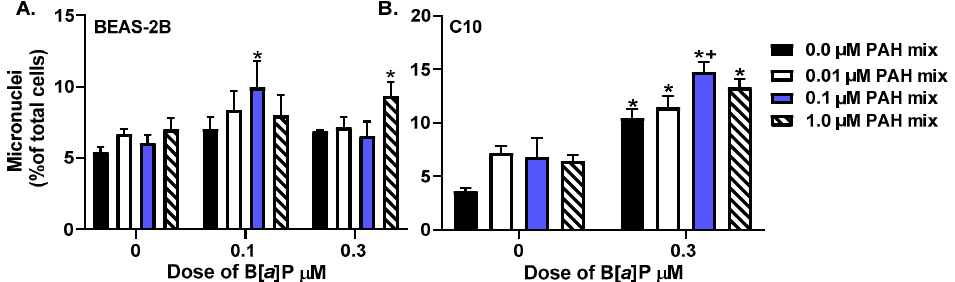
Figure 1. Micronuclei formation in human and mouse lung epithelial cells exposed to PAHs in ( A ) human BEAS-2B cells and ( B ) mouse C10 cells exposed to 0.01, 0.1, or 1 μ M of the LMW PAH mixture (1:1, Flthn:1-MeA) and either 0.1 μ M B[a]P and/or 0.3 μ M B[a]P alone or in combination with the LMW PAH mixture for 24 h. Bars represent the mean percentage of micronuclei in the total number of cells analyzed in that treatment ± SEM; n = 3 samples, repeated 3 times; * significantly different from control, B[ a ]P and LMW PAH mixtures alone; + p < 0.05, significantly different from the B[ a ]P treatment